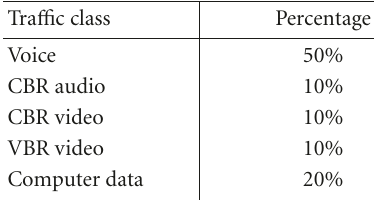
Table 4: The breakdown of the tra ffi c.